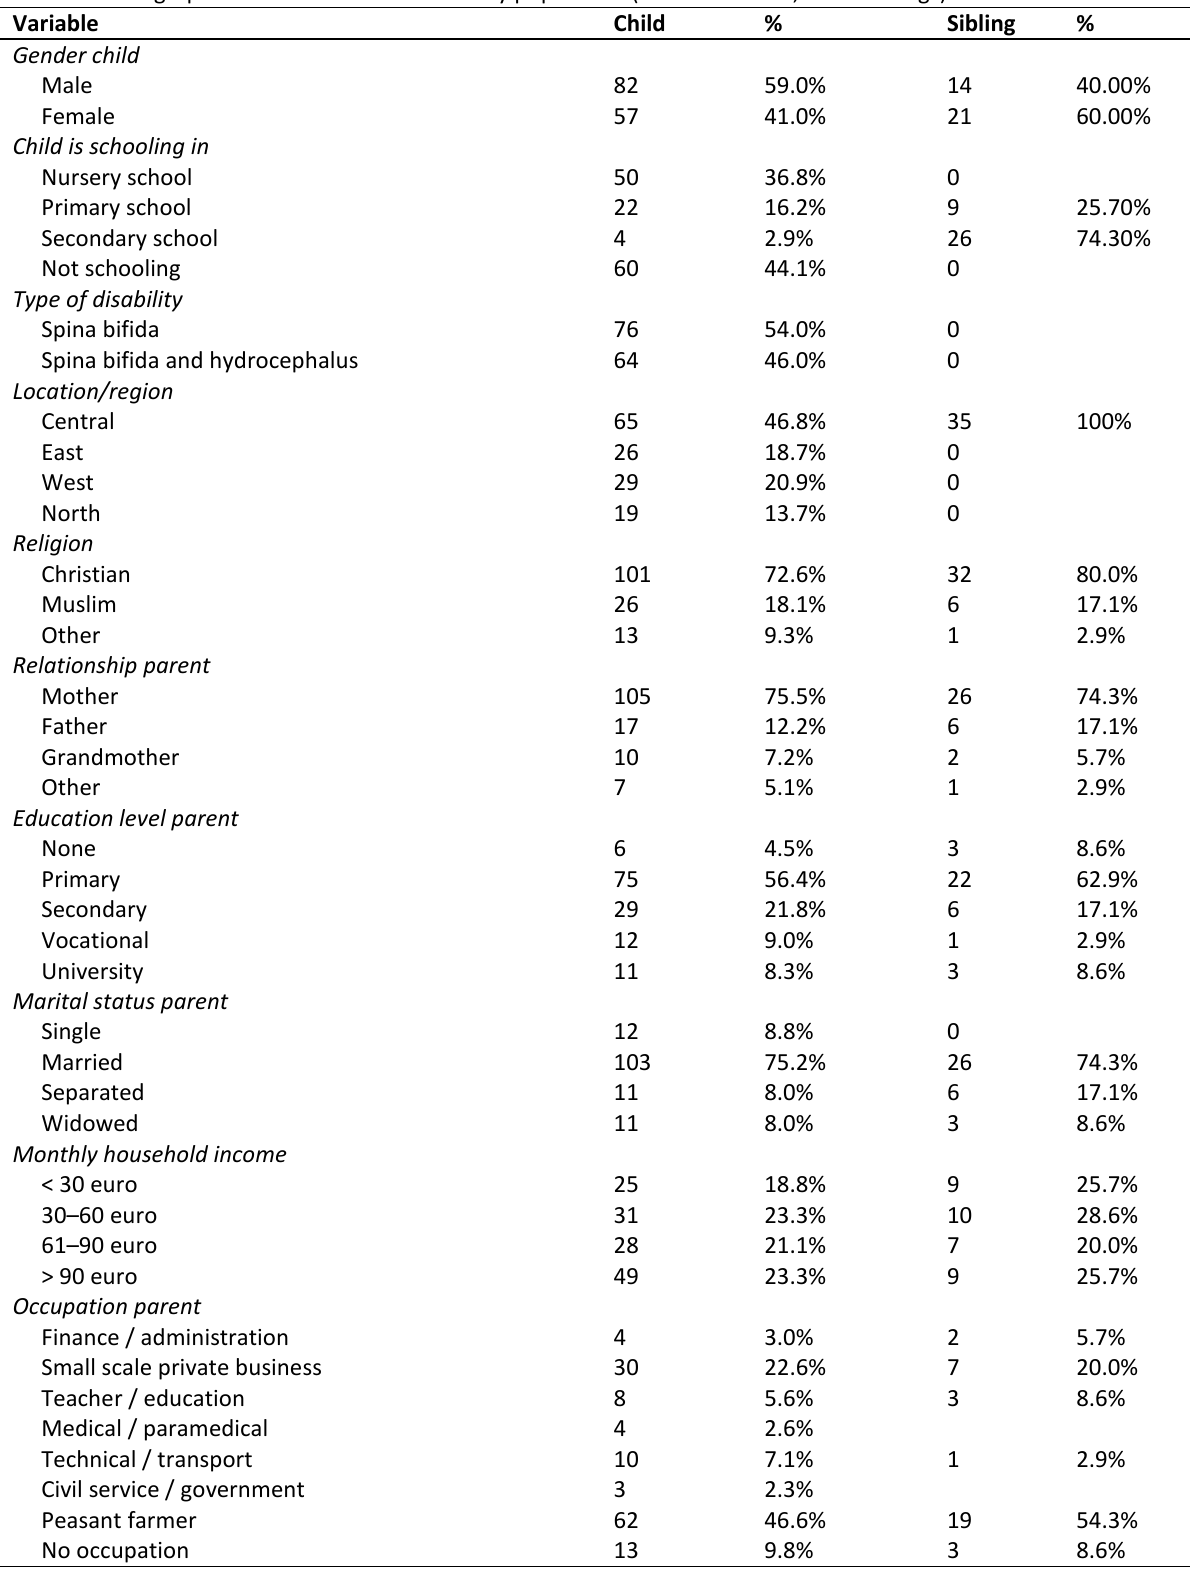
Table 1. Demographic characteristics of the study population (N=139 children, N=35 siblings) Variable